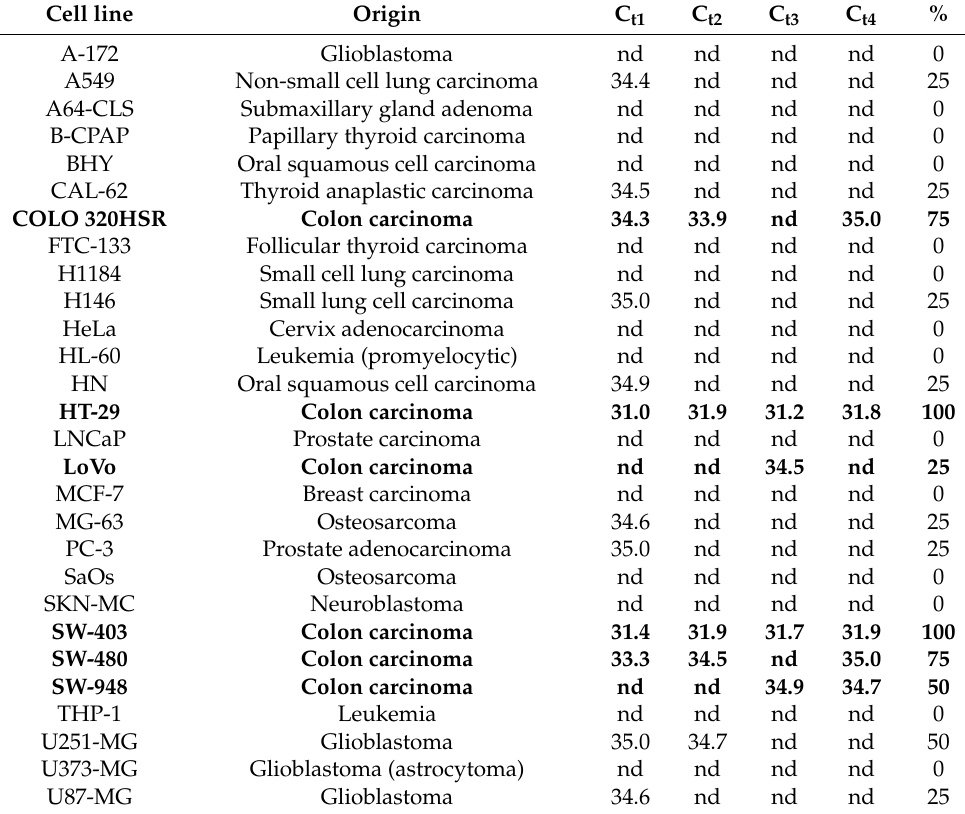
Table 1. Expression of ZP2 transcripts in human tumor cell lines as revealed by real-time PCR. Four separate RT-PCR experiments were carried out with the corresponding individual Ct-Values (Ct1 to Ct4). Percentage of expression detected in the analyzed individual samples (Ct ≤ 36) are shown in the right column (grey box with value > 0). Not detectable (Ct ≥ 37) is designated as “Nd”. Colon carcinoma cell lines are given in bold.